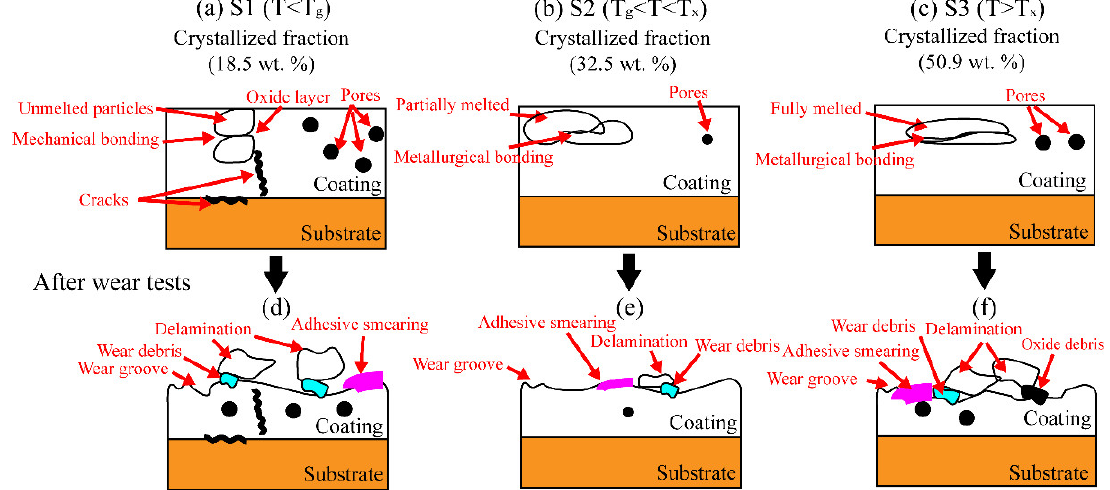
Figure 12. Schematic diagram of wear mechanisms of the three coatings. ( a , d ) S1; ( b , e ) S2; ( c , f )